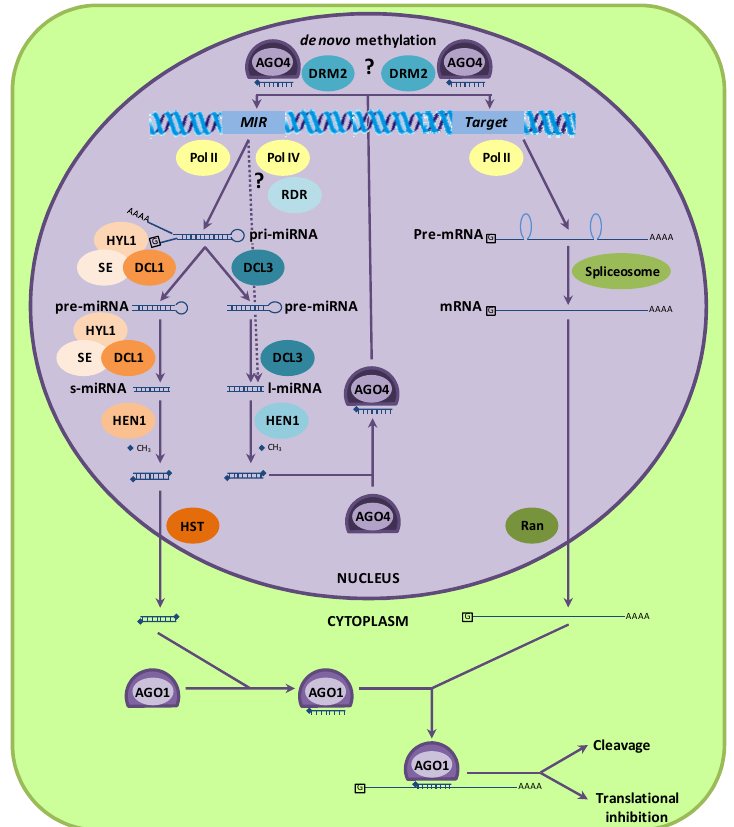
l-miRNAs in Arabidopsis are processed by the siRNA machinery, Chellappan et al . [33] talk about MIR -derived siRNAs instead of l-miRNAs. Figure 1. Model of the biogenesis and working mechanisms of miRNAs. MIR genes are transcribed by Pol II to generate a double stranded stem-loop pri-miRNA that can be further processed in short miRNAs (s-miRNAs) or long miRNAs (l-miRNAs). To produce s-miRNAs, the pri-miRNA is sliced by DCL1 and processed by HYL1 and SE. The s-miRNA/miRNA* duplex is methylated by HEN1 and exported to the cytoplasm by HST, where it associates with AGO1 into the RISC-complex. The miRNA binds with near perfect complementarity to its target mRNA to regulate it post-transcriptionally by cleavage or translational inhibition. On the other hand, to produce l-miRNAs, the pri-miRNA is sliced by DCL3 and methylated by HEN1. However, there is also the possibility that Pol IV and RDR are involved in the biogenesis of l-miRNAs. The mature l-miRNA associates with AGO4, guiding de novo DNA methylation probably catalyzed by DRM2. Abbreviations: miRNA gene ( MIR ), polymerase (Pol), RNA-dependent RNA polymerase (RDR), dicer-like (DCL), hyponastic leaves 1 (HYL1), serrate (SE), hua enhancer 1 (HEN1), hasty (HST), argonaute (AGO), domains rearranged methyltransferase 2